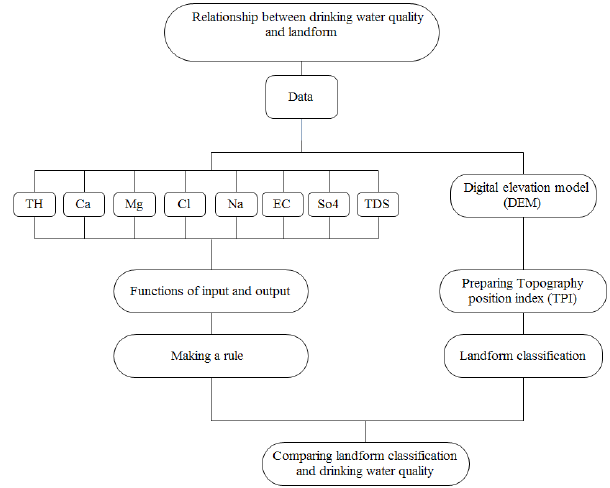
Figure 1. Flowchart for the methodology used in this study to de- termine the relationship between drinking water quality based on the content of inorganic components and landform classes.